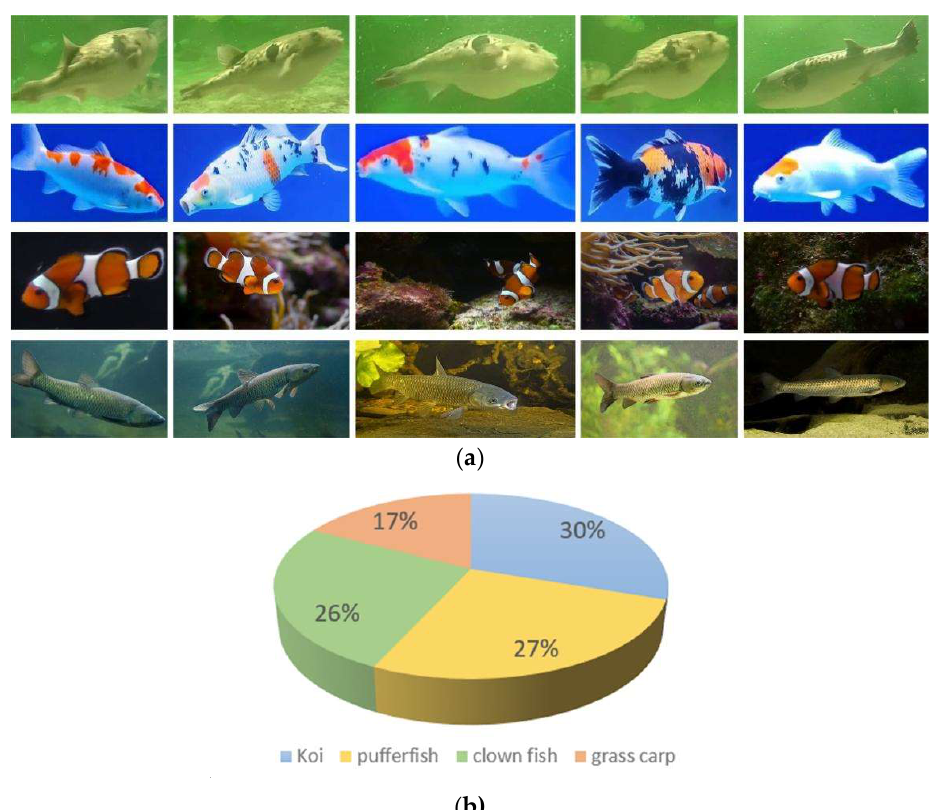
Figure 15. Example images of DlouFish dataset: ( a ) different individual fish; ( b ) the percentage of the number of various classes in the dataset.